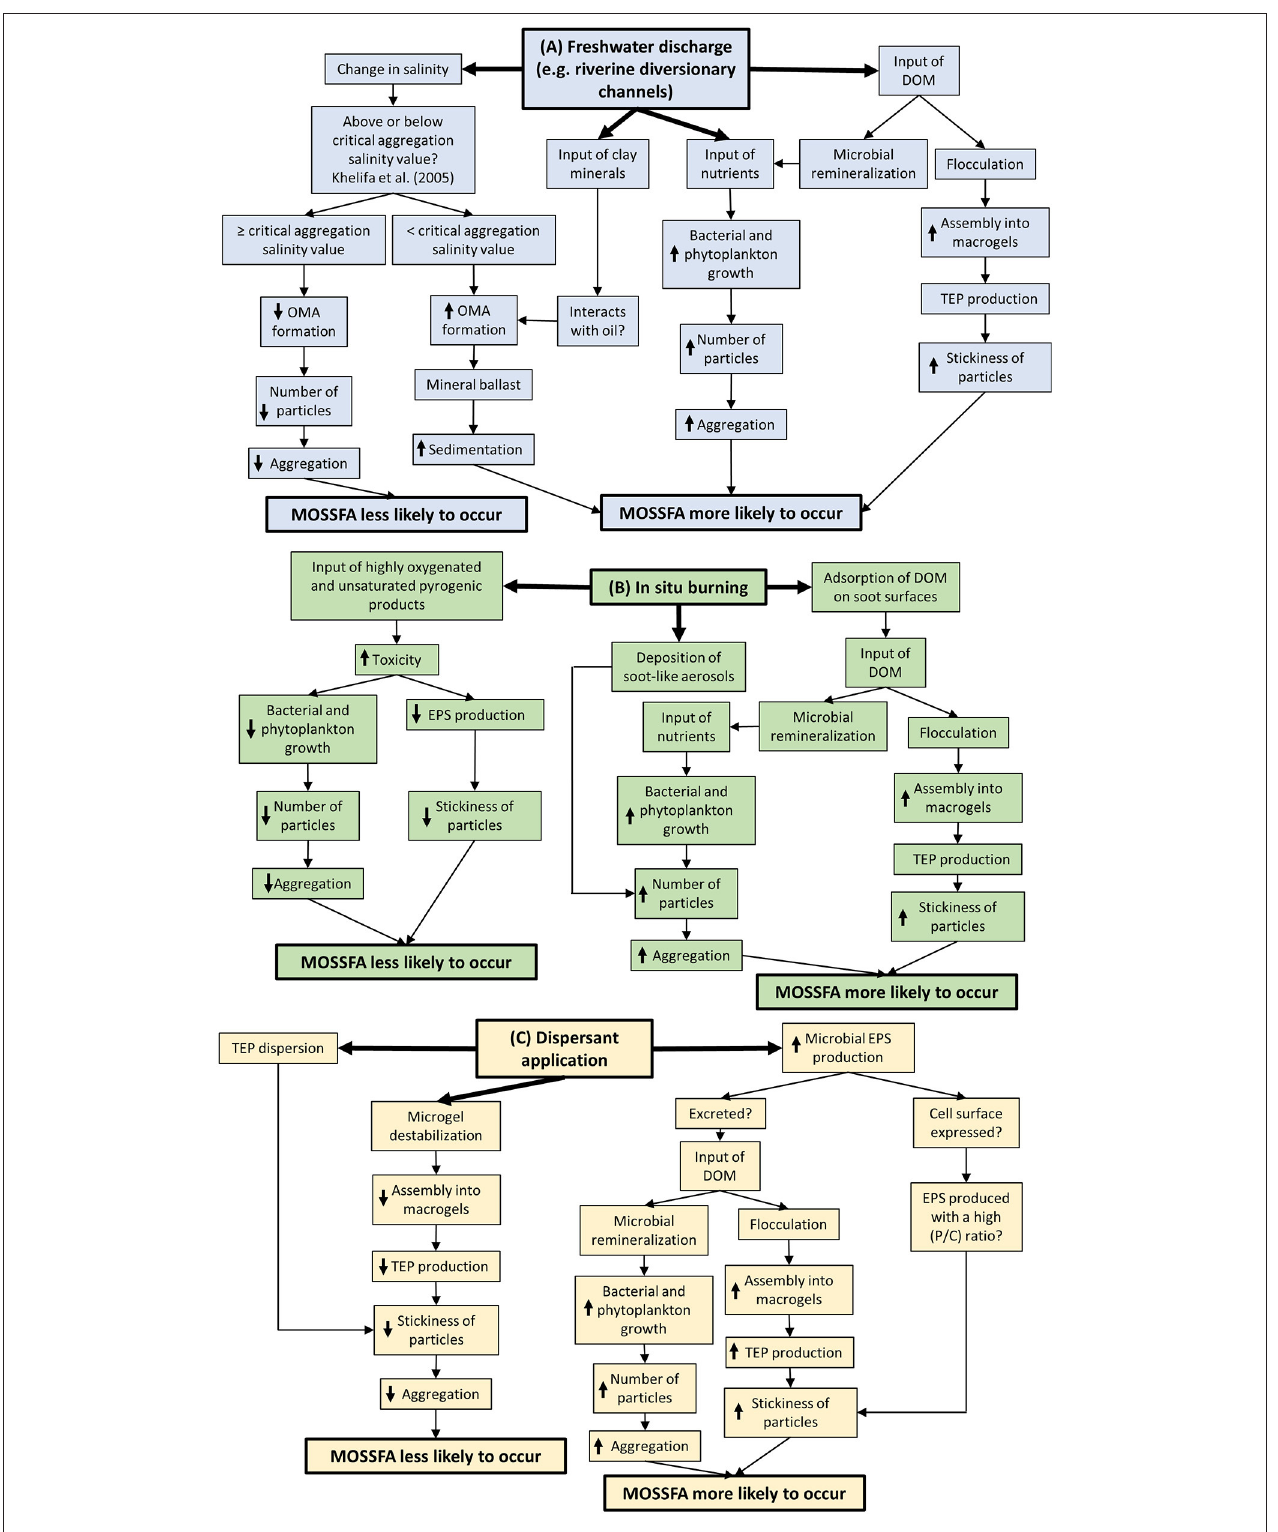
FIGURE 2 | A mind-map showing the factors that may influence the likelihood of a marine oil snow sedimentation and flocculent accumulation (MOSSFA) event, (A) in the event of freshwater influence from rivers, and (B) and (C) after common oil-spill-response strategies, such as (B) in-situ burning, and (C) dispersant application. Abbreviations include: dissolved organic matter (DOM), extracellular polymeric substances (EPS), oil-mineral aggregates (OMA), protein/carbohydrate ratio (P/C ratio) and transparent exopolymer particles (TEP). Up-arrows denote an increase of the process and down-arrows denote a decrease.